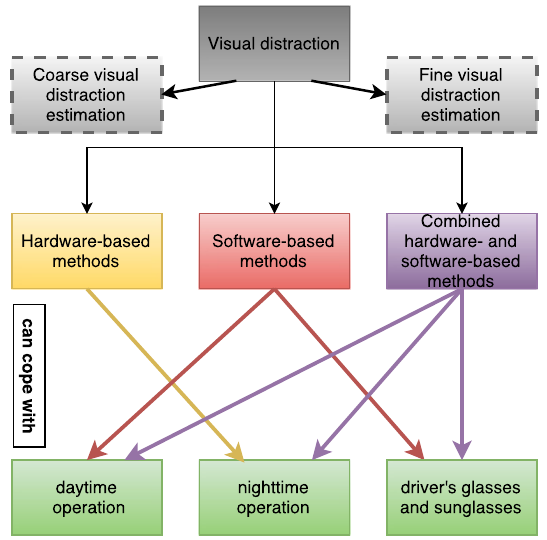
Figure 4. Visual distraction algorithms